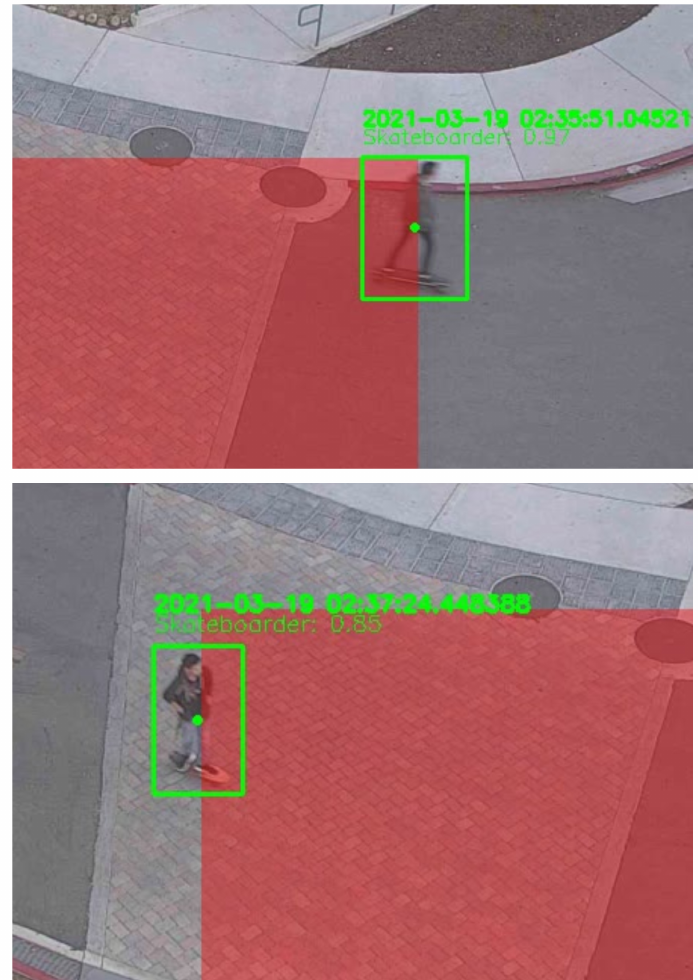
Figure 22. The egress time for the first skateboarder occurs at 2:35:51.04. The ingress time of the following skateboarder occurs at 2:37:24.44.PET for this pair of entities is ∆ t = 2:37:24.44 − 2:35:51.04 = 93.4 s.